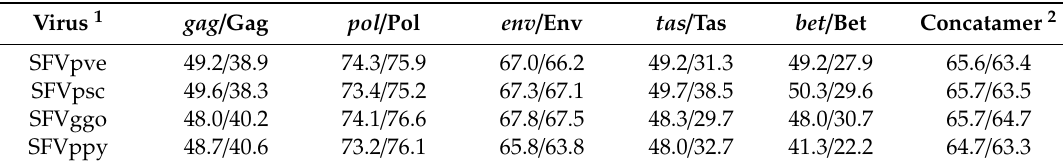
Table 3. Percent nucleotide and amino acid identity comparisons of SFVhpi_SAM106 compared to SFVs of other ape